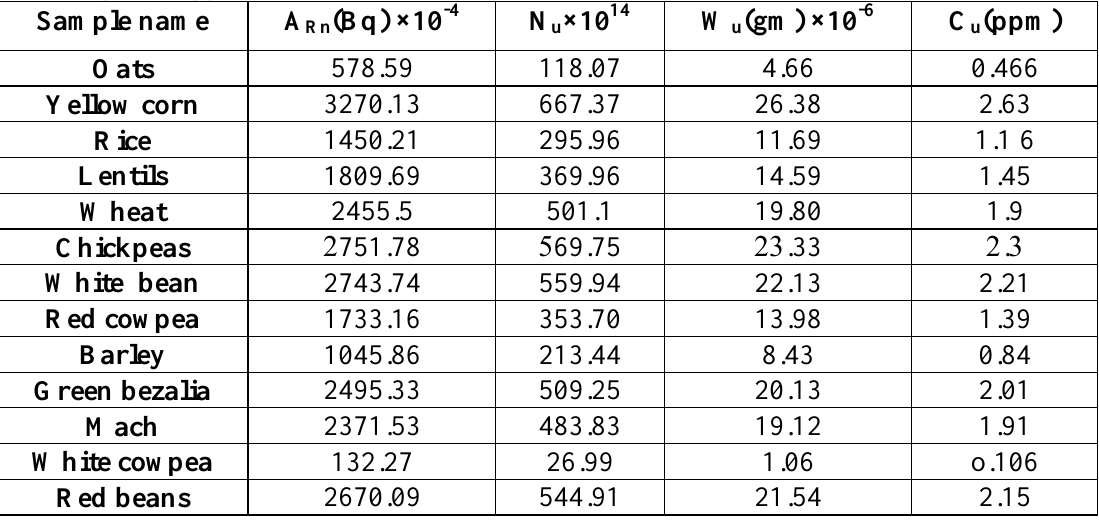
Table 2: Radiation activity of radon, number of uranium atoms, weight and concentration of samples in